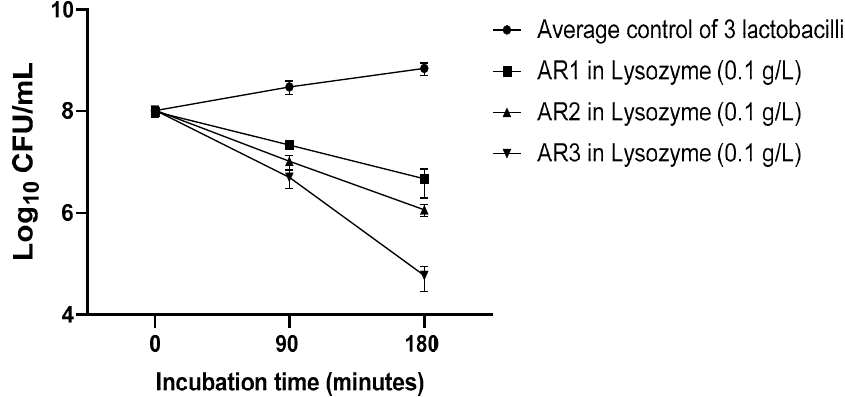
Figure 1. Lysozyme resistance assay of L. acidophilus AR1, L. acidophilus AR2, and L. fermentum